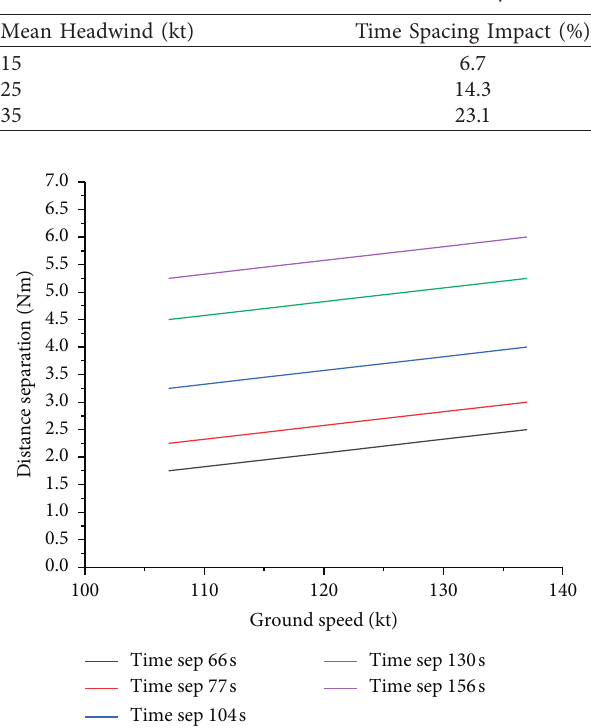
Table 7: Wake separation based on RECAT-CN (nautical miles). Follower